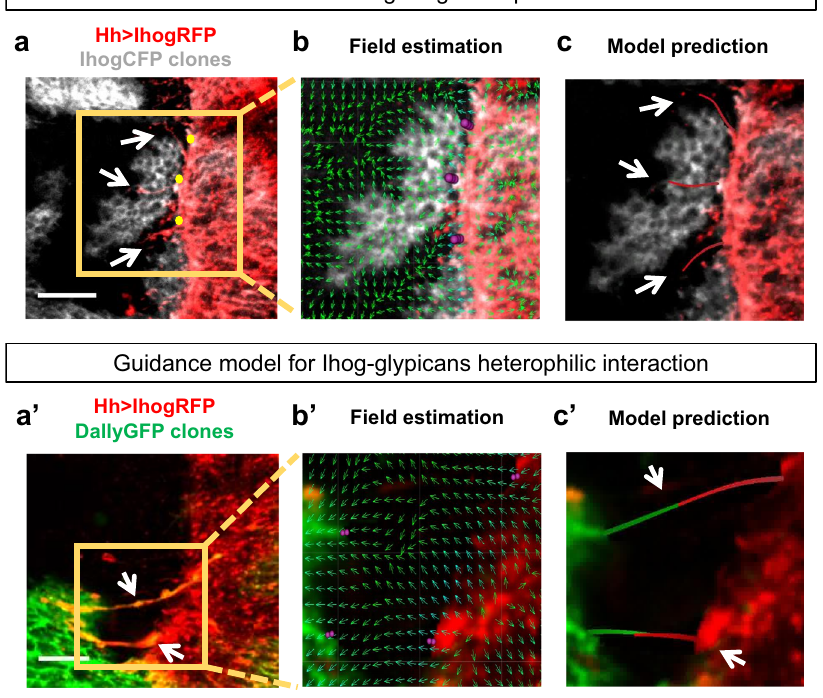
Fig. 5 | Experimental validation of the guidance model. a P compartment cells overexpressing Ihog confronted to clones also overexpressing Ihog. White arrows indicatethosecytonemestobesimulated. b Guidance fi eldestimation(greensmall arrows) of the experimental conditions eliminating selected cytonemes. c In silico predicted trajectories for the simulated cytonemes. a ’ P compartment cells